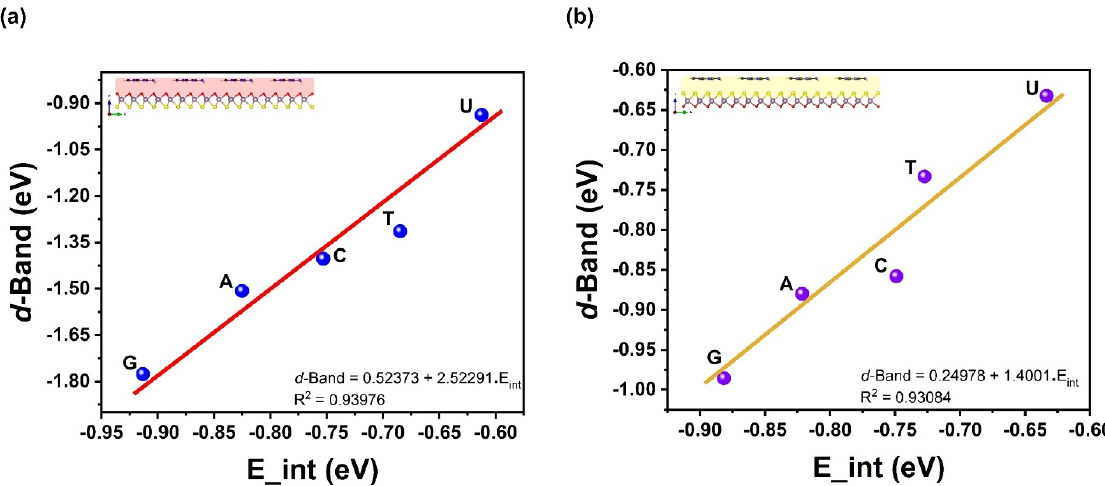
Figure 7. The d -band center energy as function of interaction energy of the nucleobases molecules on the Janus MoOS monolayer facets, ( a ) on O layer, ( b ) on S layer,